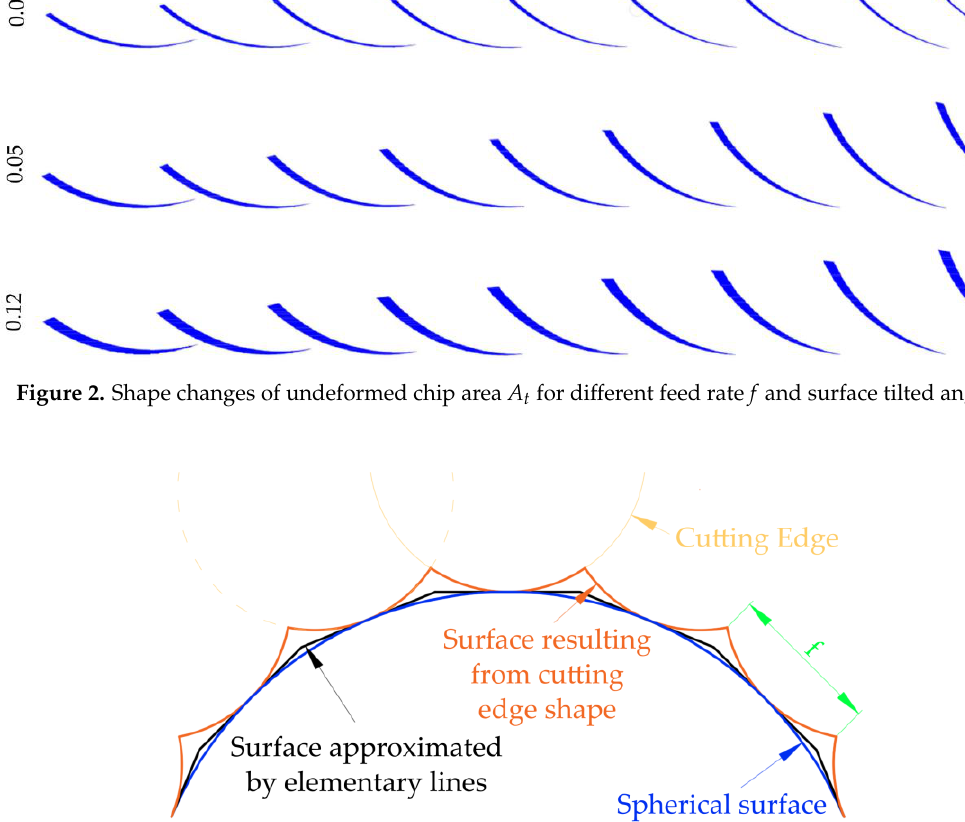
Figure 3. Scheme of determining the fundamental straight lines.